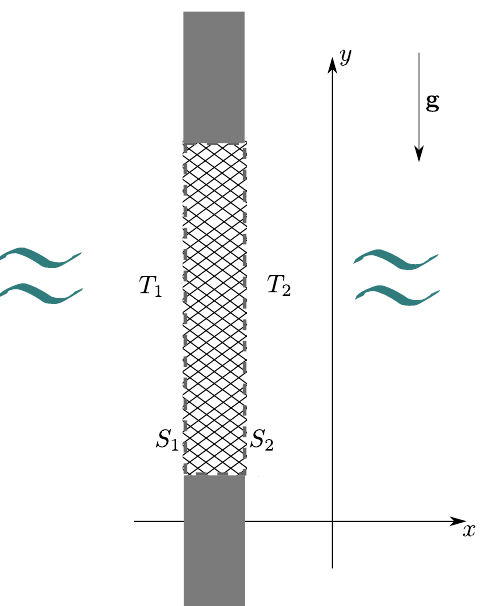
Figure 3. Sketch of the porous slab separating two fluid reservoirs discussed in Section